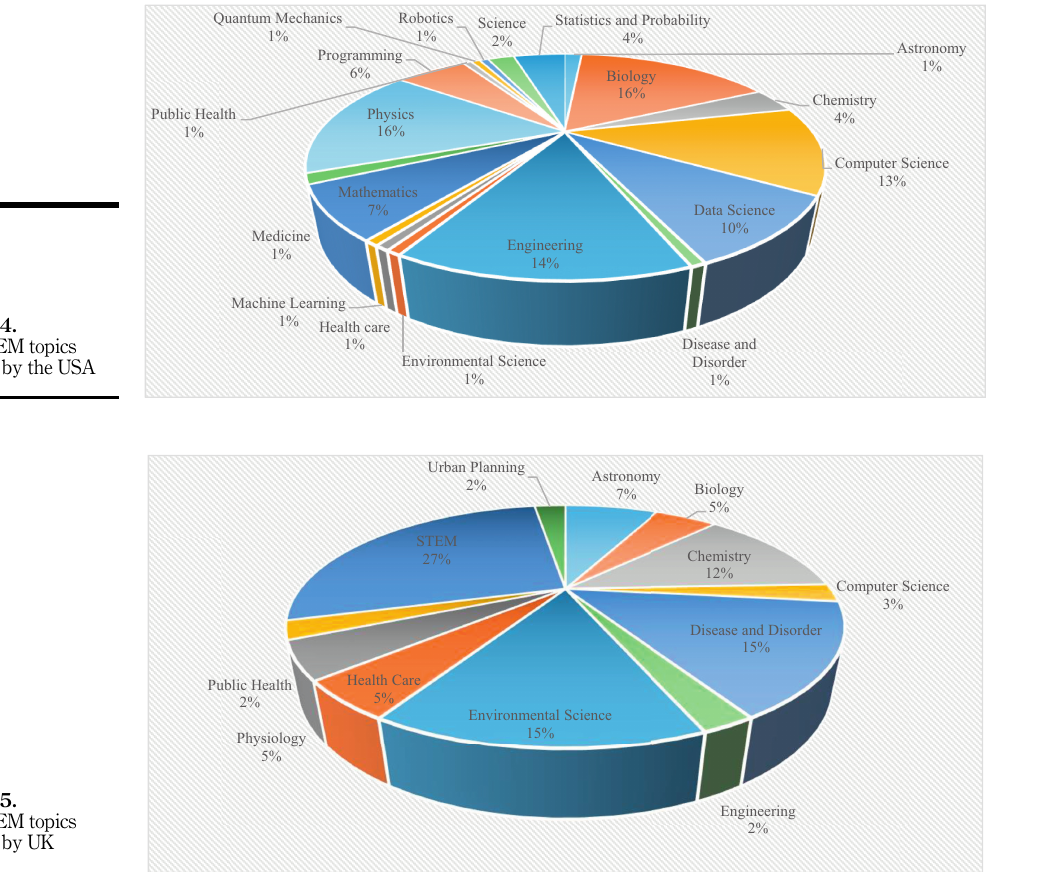
Figure 5. The STEM topics covered by